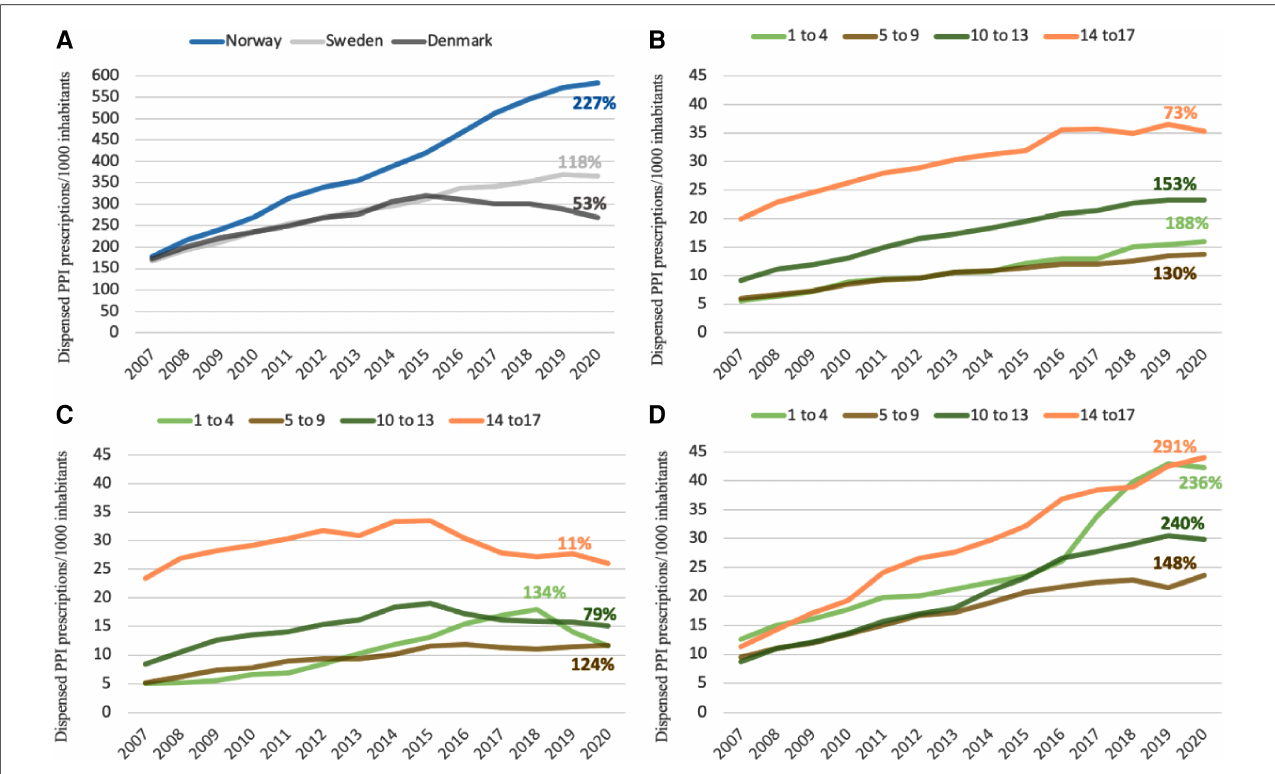
FIGURE 1 ( A – D ): temporal changes of PPIs by age and country. Percentages showing the increase in dispensations of PPIs for each age group and each country from 2007 to 2020. A=All countries, B=Sweden, C=Denmark,